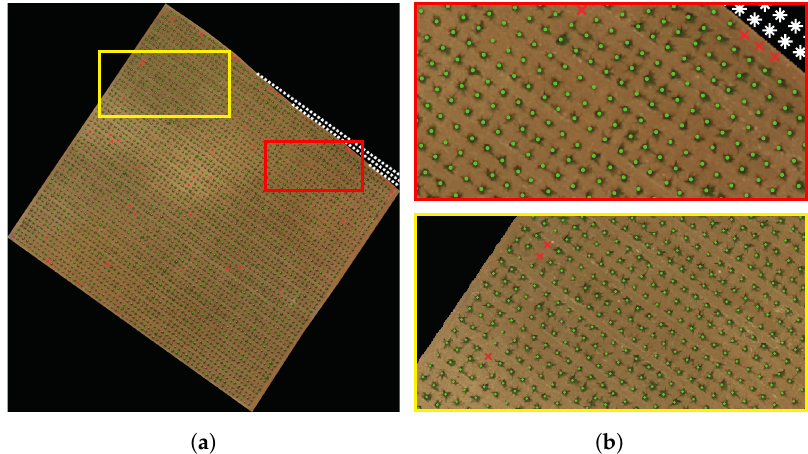
Figure 12. Living and missing vine identification. ( a ): whole image, ( b ): magnified